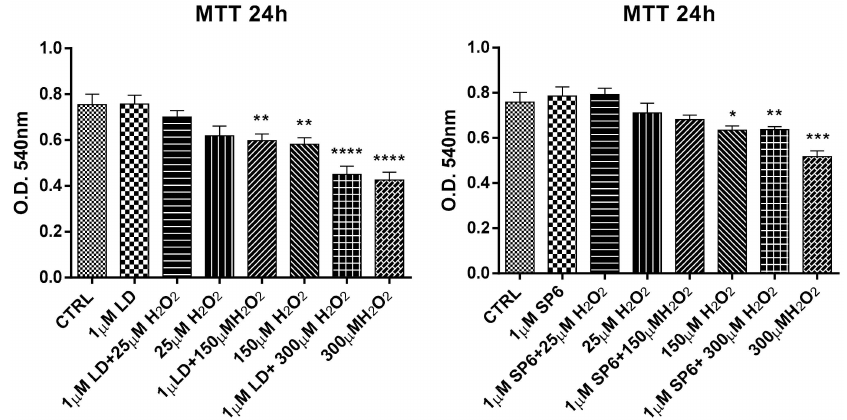
Figure 7. Neuroprotective e ff ect of LD and SP6 against H 2 O 2 in RA / PMA-di ff erentiated SH-SY5Y human neuroblastoma cells. The MTT reduction assay in di ff erentiated and H 2 O 2 -lesioned SH-SY5Y human neuroblastoma cells in the presence of LD and SP6 . The cells were incubated with the compounds (1 µ M) 24 h before and during a 24 h incubation period with increasing concentrations (25, 150, or 300 µ M) of H 2 O 2 . After this period, cell viability was quantified by measuring the MTT reduction. CTRL: control without compounds. The means ± SEM derived from three di ff erent experiments (each with n = 16; **** p < 0.0001; *** 0.0001 < p < 0.0005; ** 0.0005 < p < 0.001; * 0.001 < p < 0.05; n.s., p >